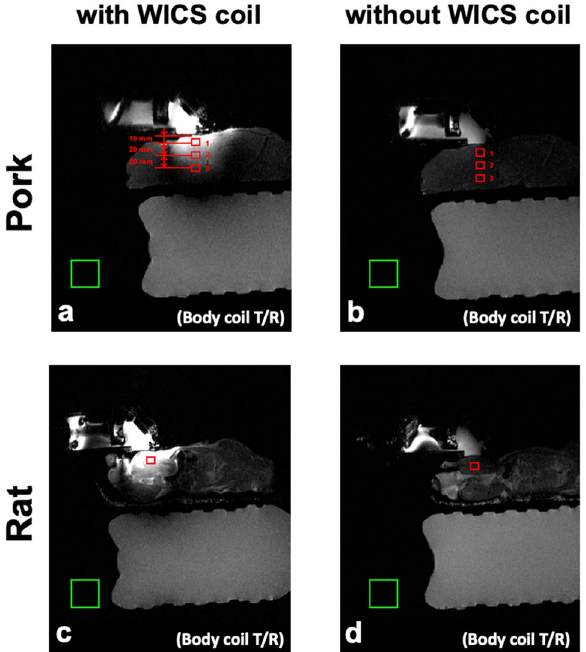
Figure 5. Representative T2 weighted images of rats (bottom row) and pork tenderloins (top row) obtained with ( a , c ) and without ( b , d ) WICS coil from ex vivo experiments. Each ROI contains 25 pixels for SNR measurement, as shown in red